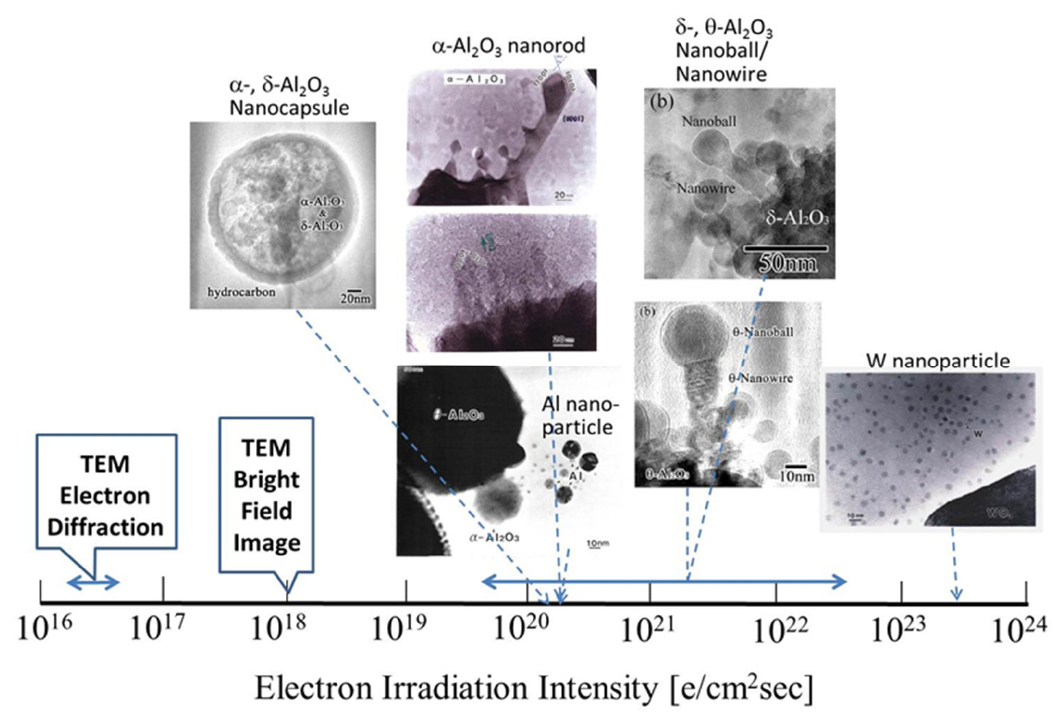
Figure 28. Nanostructured materials obtained by electron irradiation in TEM. Nanoparticles and nanosized oxides can be induced in an electron excited reaction field. The electron irradiation intensity ranged from 10 20 –10 23 e/cm 2 s depending on the specific gravity of the materials and the metal-oxygen binding enthalpy of the starting oxide.